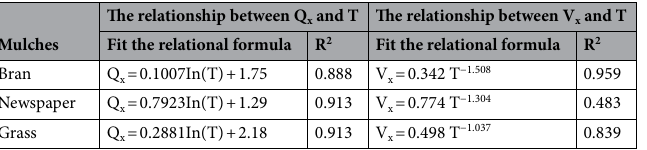
Table 2. Regression equation for water holding and immersion time of different organic mulches.